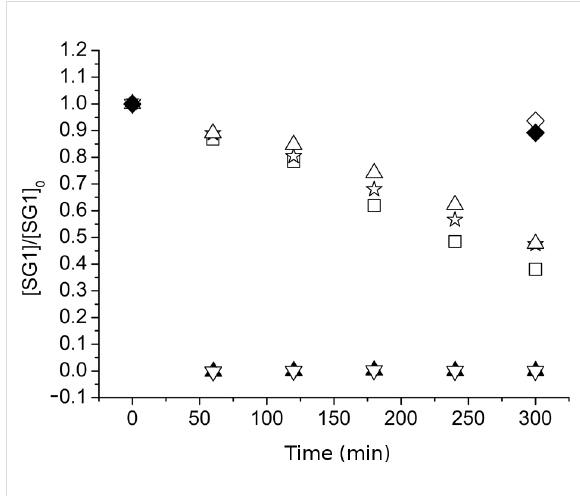
Figure 6: Degradation of the SG1 nitroxide versus time in the pres- ence of 0% of lithium salt in DMA (empty squares); DMF (empty trian- gles) and MeOH (empty diamonds), 4.5 or 10 wt % of LiCl in DMA or DMF (filled triangles), 4.5 wt % of LiBr in DMA (reverse filled triangles), 4.5 wt % of LiCl in MeOH (filled diamonds) and 4.5 wt % of NaCl in DMA (empty stars) as measured by ESR in t-BuPh at 25 °C (samples